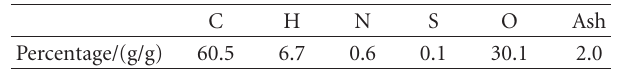
Table 2: Elemental analysis of enzymatic hydrolysis lignin from SEKAB (Sweden).